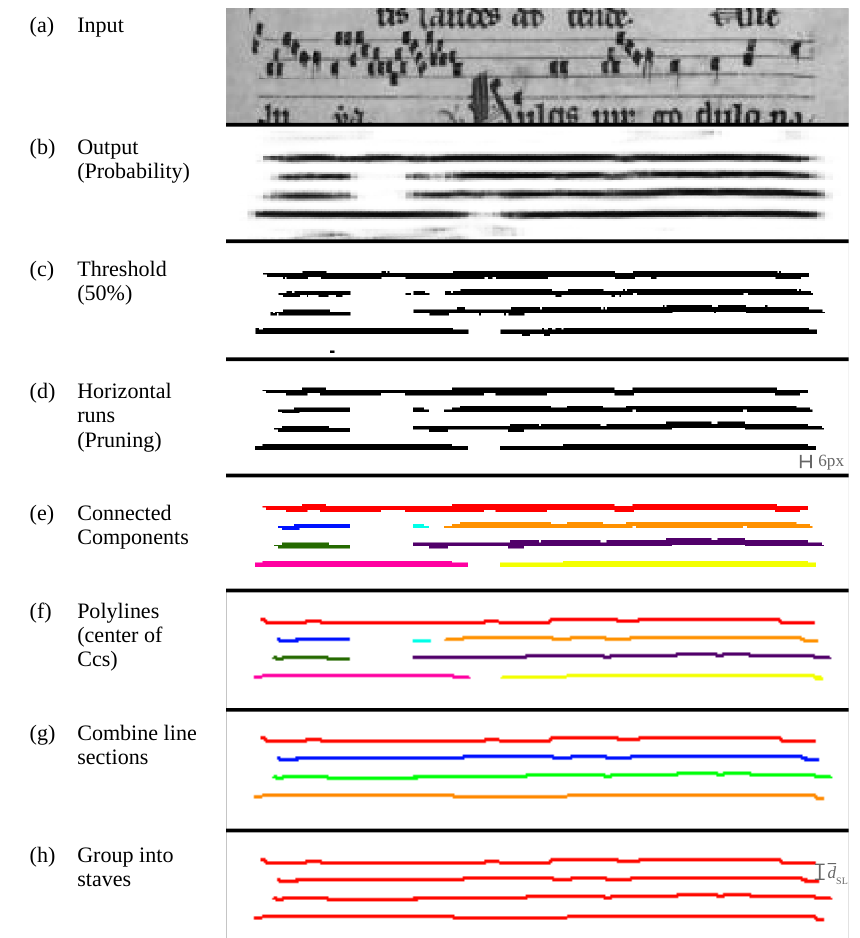
Figure 6. Staff line detection steps including the application of the FCN and the postprocessing.